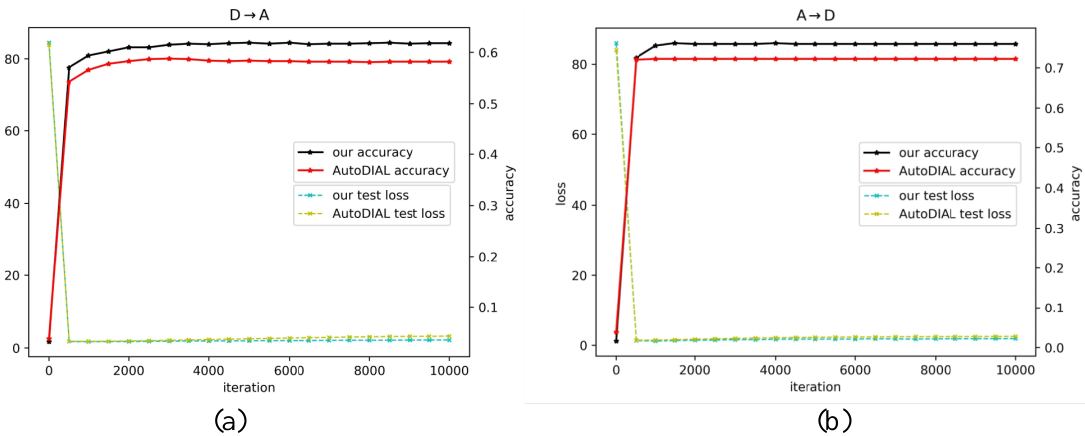
Figure 3. Comparison with the AutoDial method: ( a ) accuracy and test loss for task D → A; ( b ) ac- curacy and test loss for task A → D.